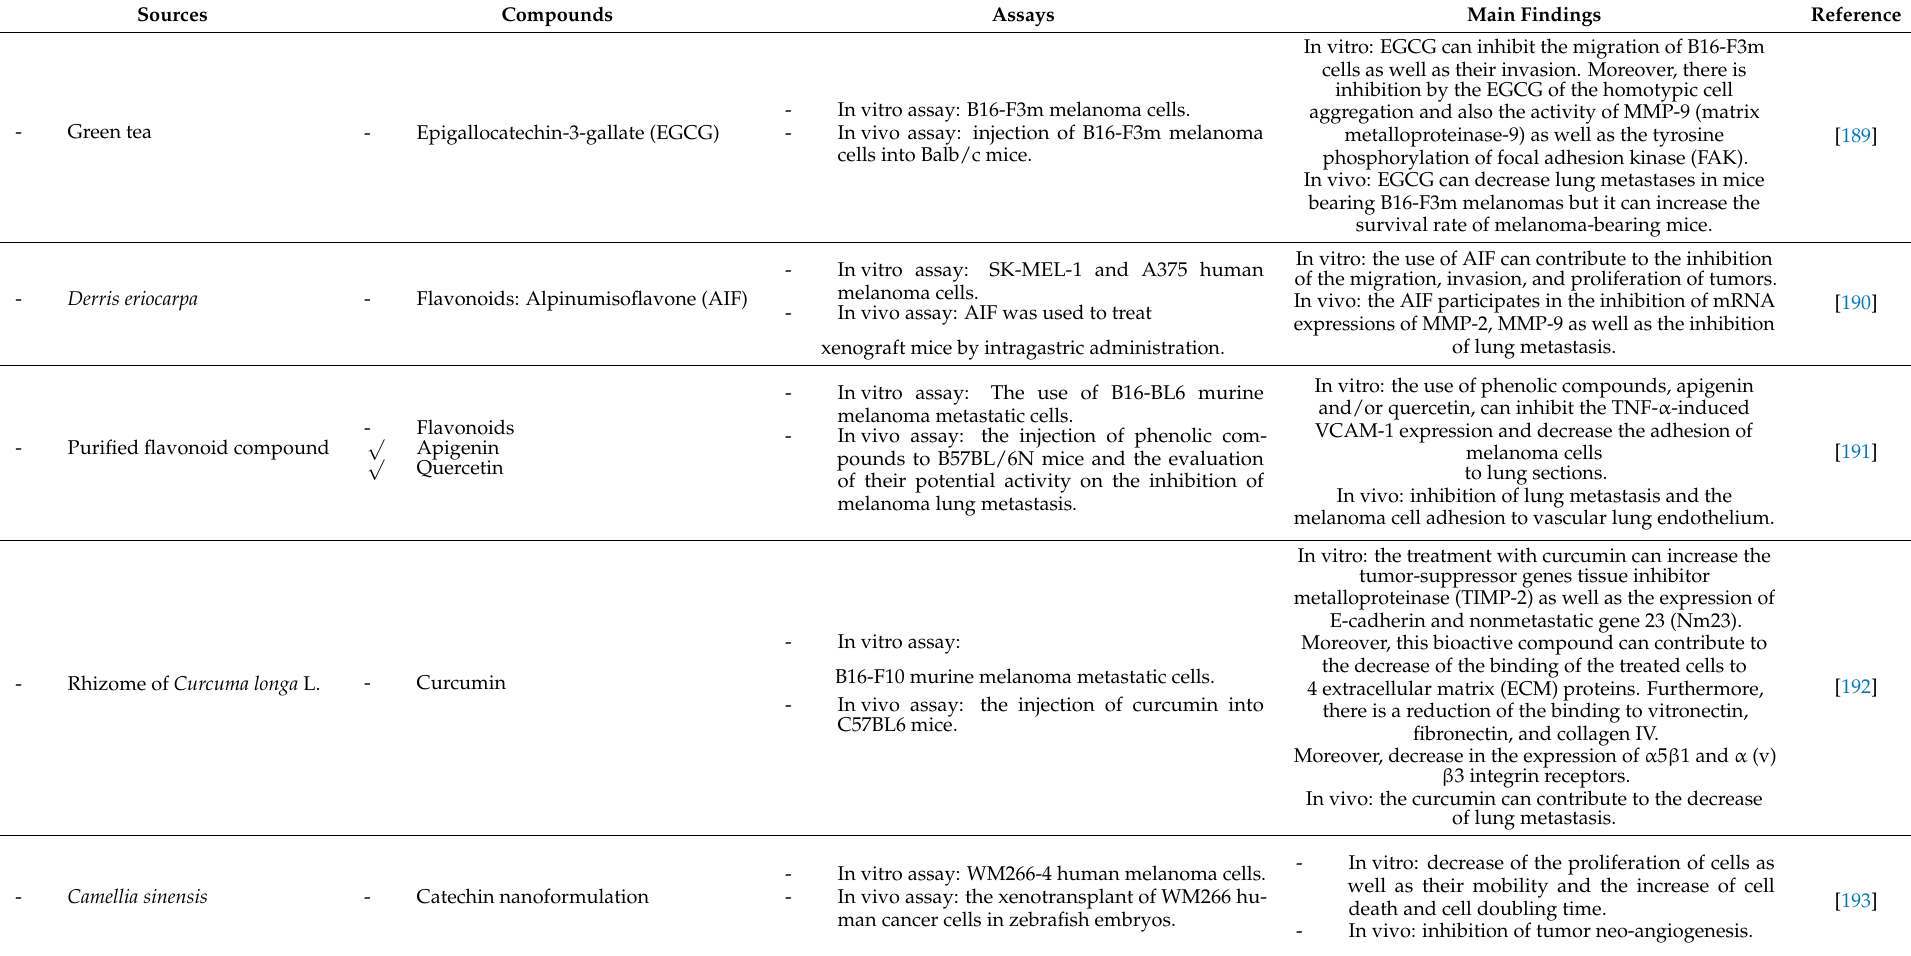
Table 5. The anticancer properties of some phenolic